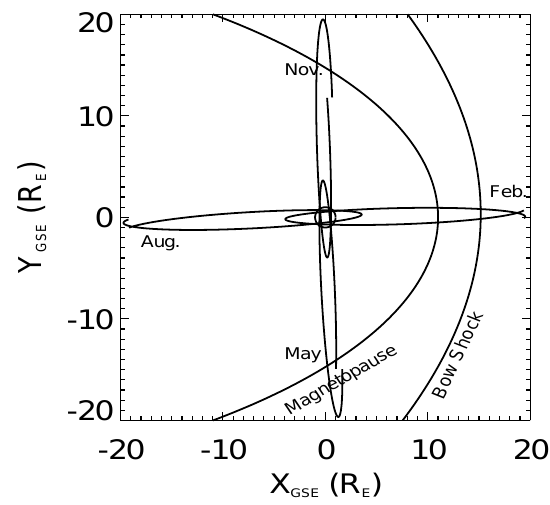
Fig. 1. Orbits of the Cluster spacecraft projected onto the equatorial plane. The orbits are shown at three-month intervals, starting with the 2nd launch in August 2000.